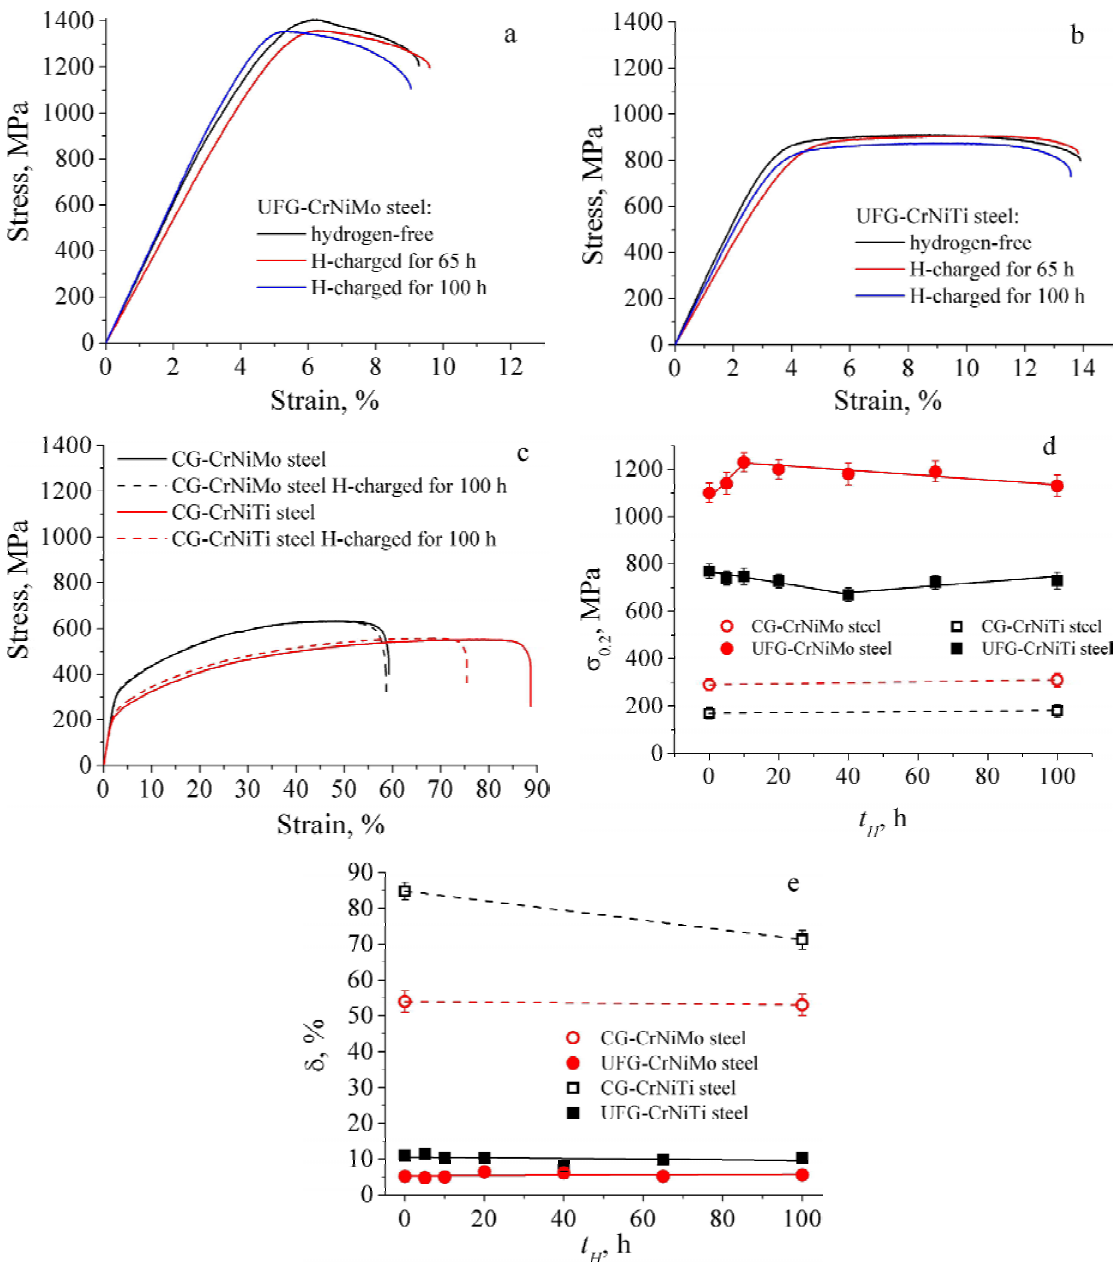
Fig. 3. The effect of hydrogen-charging on engineering stress-engineering strain curves for ultrafine-grained UFG-CrNiMo (a) and UFG-CrNiTi (b) steels and coarse-grained CG-CrNiMo and CG-CrNiTi steels (c) under tension. Data on 0.2% proof stresses (d) and elongation (e) depending on hydrogen-charging duration for ultrafine-grained and coarse-grained